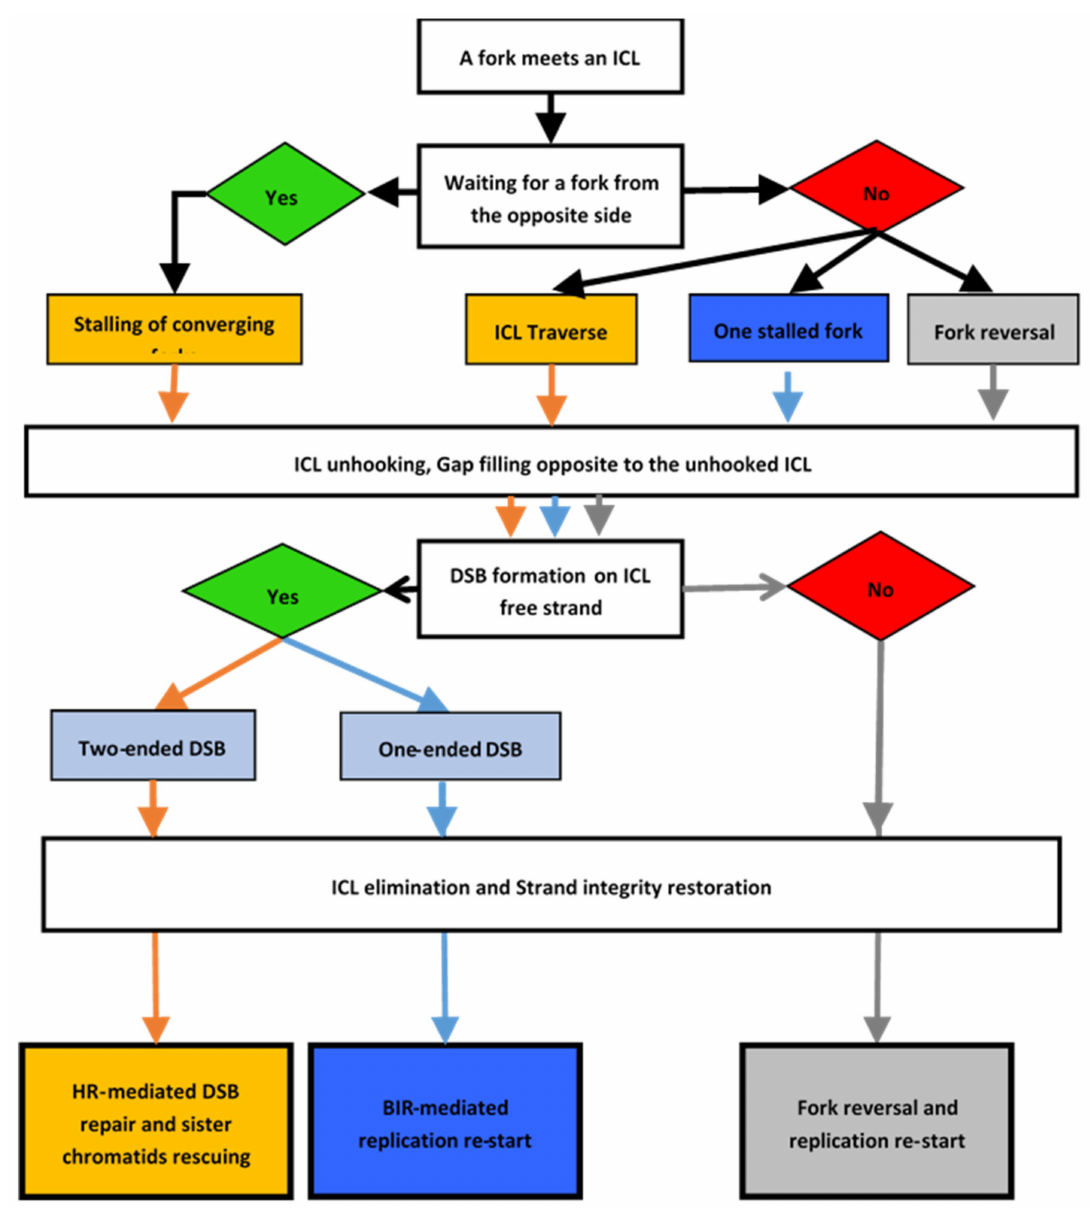
Figure 4. DNA interstrand cross-link (ICL)-repair decision process. Schematic showing the various options o ff ered to a cell when a replication fork faces an ICL. The schematic describes the choices to repair the ICL and the associated DSB until replication is able to resume. The colors illustrate the di ff erent paths available to a cell depending on the type of ICL